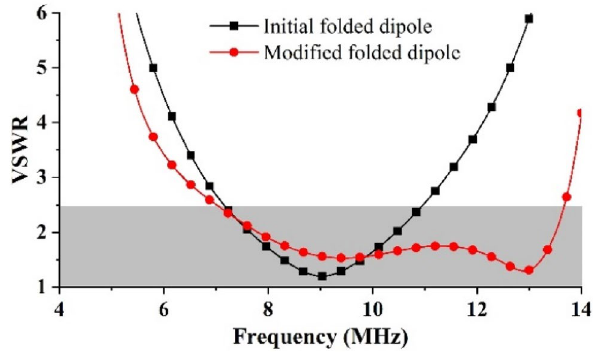
Figure 4. Simulated VSWRs of initial and modified folded dipole.